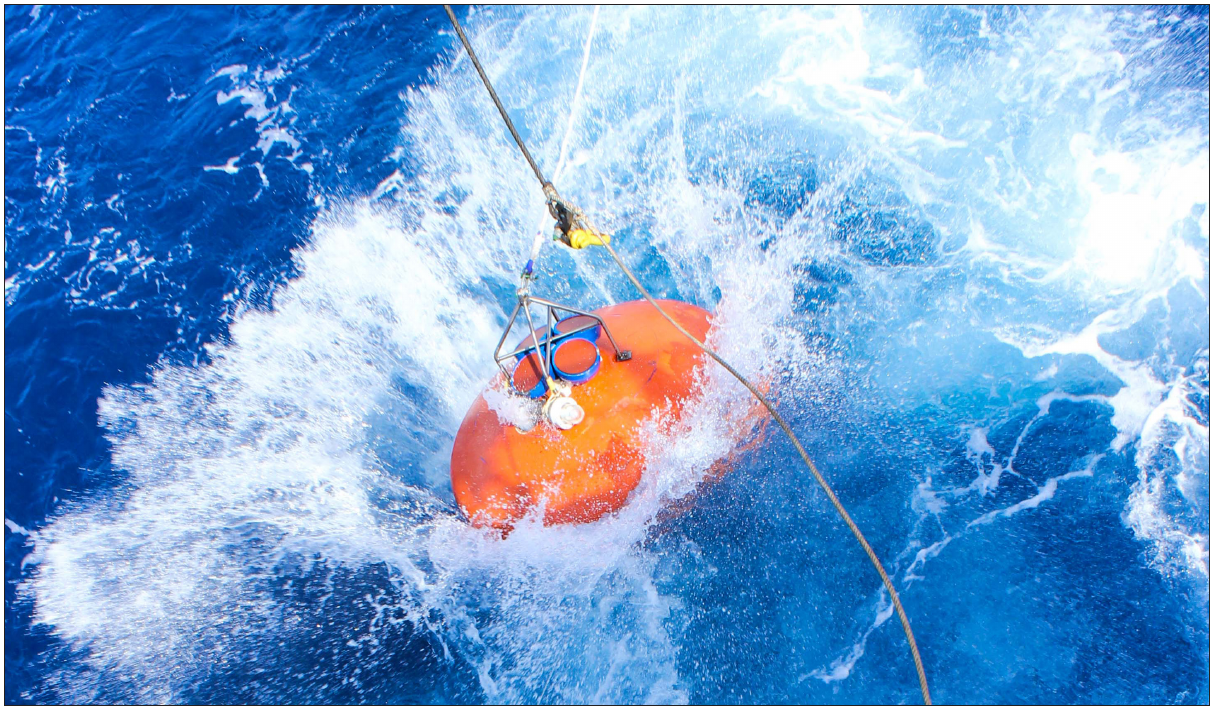
Figure 3: Top float deployment, showing the elliptical float and acoustic Doppler current profiler of a tall